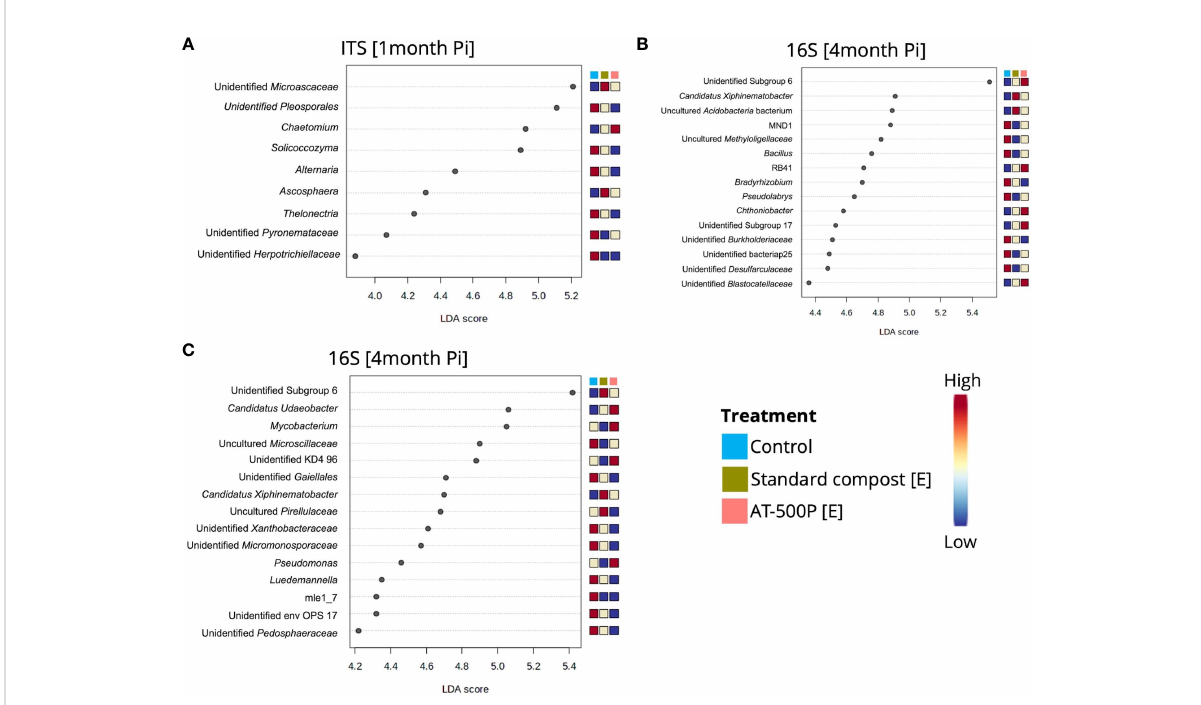
FIGURE 4 Dot plot representation of differentially abundant genera in treatments which showed signi fi cant pairwise differences to the control for the different orchards and sampling times. (A) shows differentially abundant fungal genera at one-month post inoculation in organic orchard, while (B, C) represent signi fi cant differentially abundant bacterial genera between treatment and control in organic and integrated orchard at four- months post inoculation, respectively. The signi fi cant (P<0.05) differentially abundant genera were obtained by LEfSe, and the genera with high LDA scores (3 to 6) were shown. The [E] in the legend represents extract, and the coloured scale bar represents relative abundances, with the lowest indicated as blue, and highest as